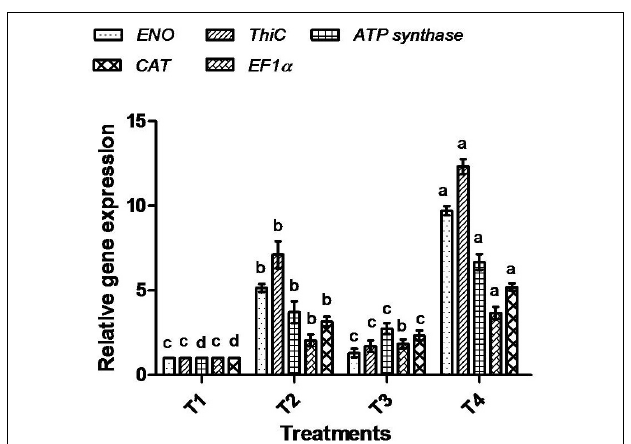
FIGURE 11 | Effect of bacterial (BHU-AV3) inoculation on expression of selected proteins’ mRNA in roots under salt stress. T1 – control, T2 – salt (NaCl), T3 – bacterial (BHU-AV3) inoculation, and T4 – bacterial inoculation + salt. Values represent the mean ± SD, n = 3. Different letters on each bar indicate significant differences ( P = 0.05) after DMRT